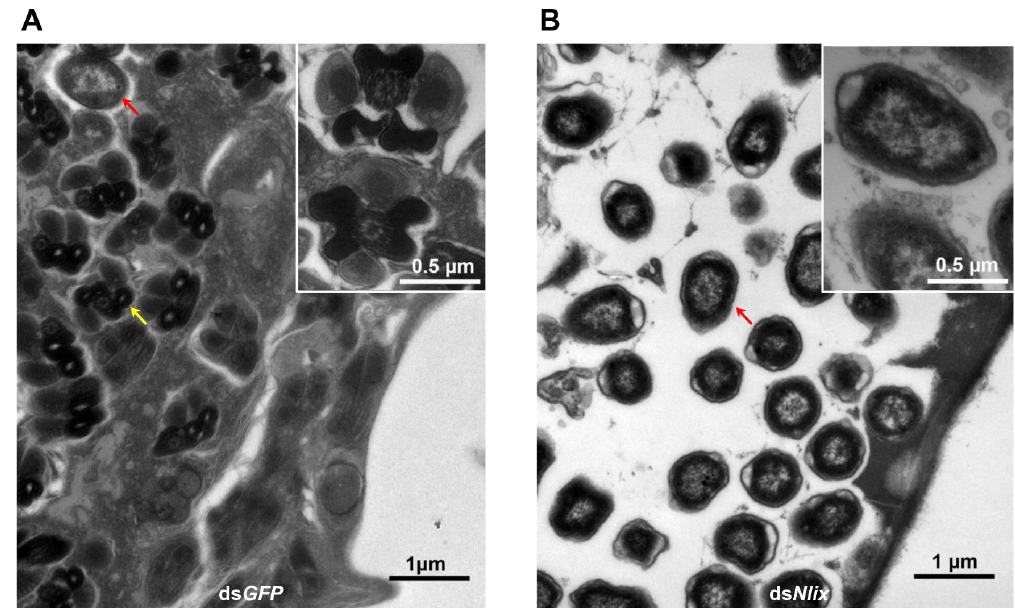
Figure 2. Transmission electron microscopy observation of copulatory bursa from the 72 h females in ( A ) the ds GFP -injected sample, ( B ) the ds Nlix -injected sample. A clearer view of the sperms/bacteria is shown in the top right corner of each panel. The yellow arrow marks the sperm and the red arrow marks the bacteria in the copulatory bursa.